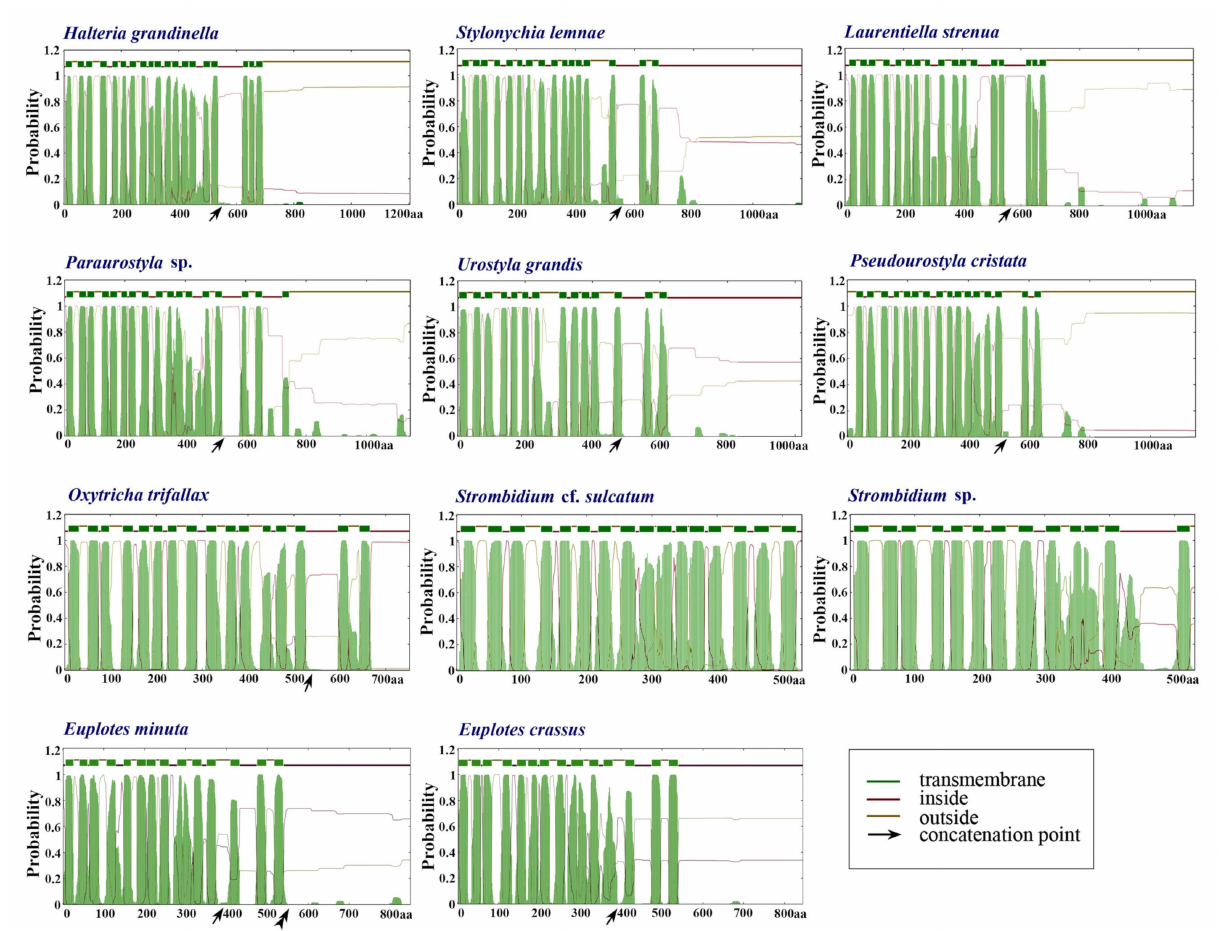
Figure 5. Transmembrane (TM) profiles for the concatenated ccmf proteins of eleven representative mitogenomes in the class Spirotrichea. The x and y axes denote amino acid length and posterior probabilities detected by TMHMM v.2.0, respectively. The green blocks represent TM regions. The arrow indicates concatenation point of ccmf_i and ccmf_ii. The double arrowheads denote the pseudo split of ccmf_ii in Euplotes minuta